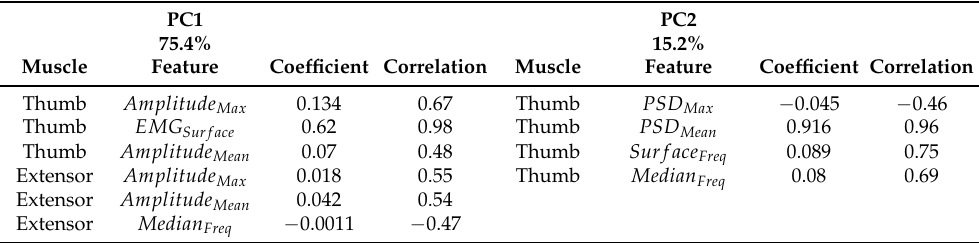
Table 7. PC coefficients and correlations between features and corresponding PC for the fourth scenario. Only | r | > 0.4 are shown.